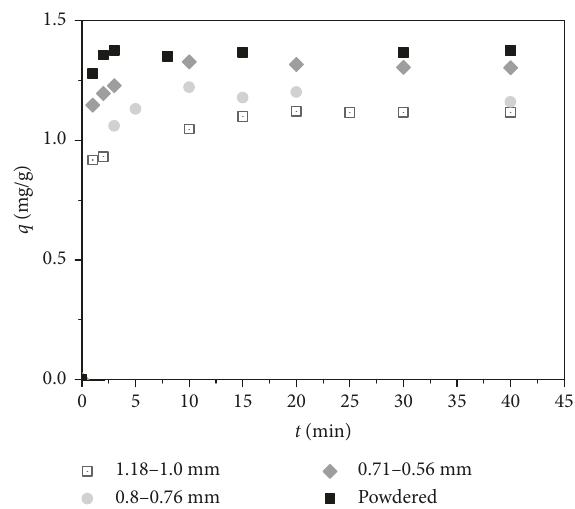
Figure 7: Effect of the particular size on cobalt adsorption using MCSG60A. Conditions: [Co 2+ ] sorbent dosage